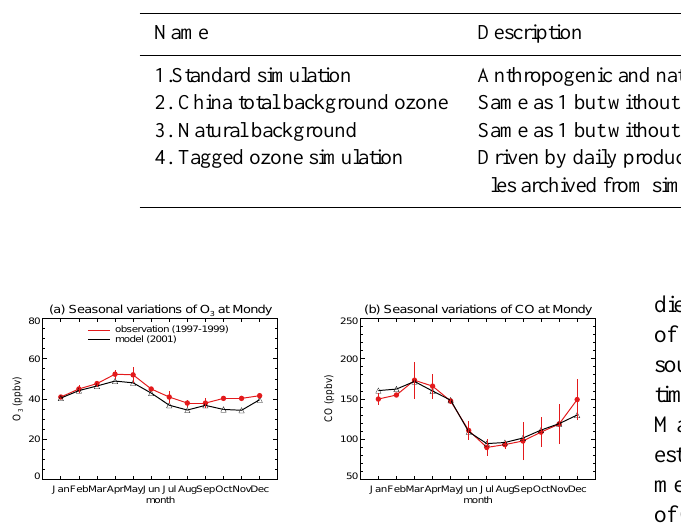
Fig. 1. Monthly mean O 3 (a) and CO (b) mixing ratios (ppbv) of observation (red circles) and model (black triangels) at the Mondy